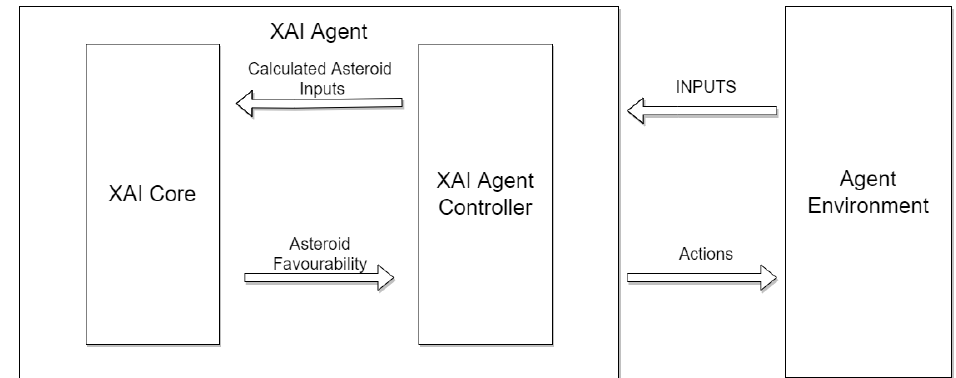
Figure 2. XAI agent block diagram.